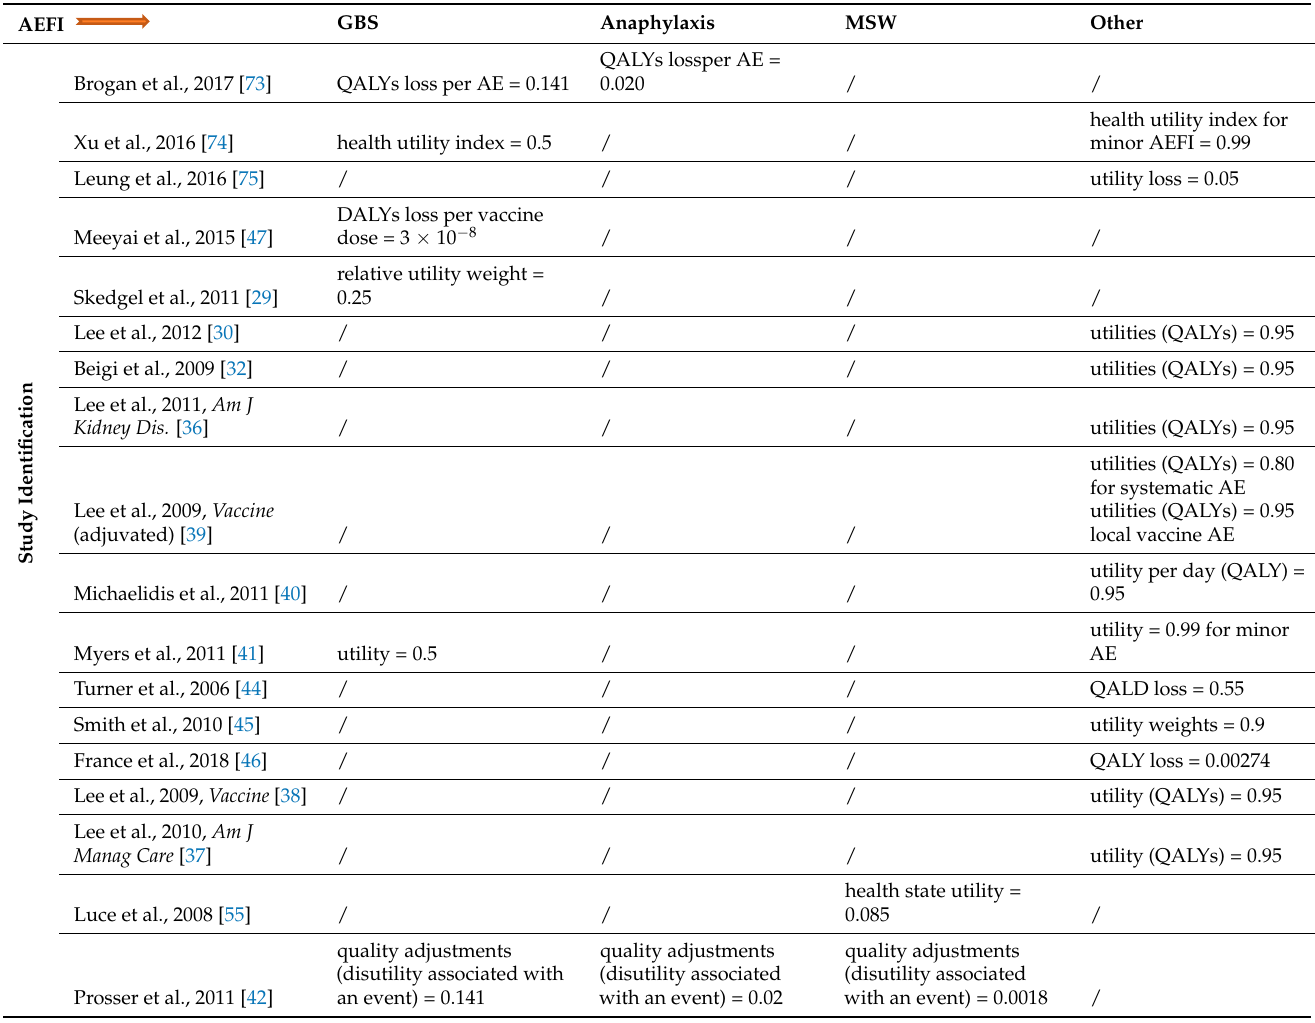
Table 5. AEFI-related disutility among economic evaluations on seasonal influenza vaccine. Table 5. AEFI ‐ related disutility among economic evaluations on seasonal influenza